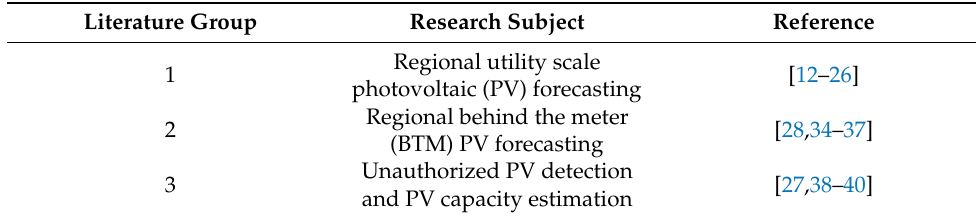
Table 1. Literature reviews classification